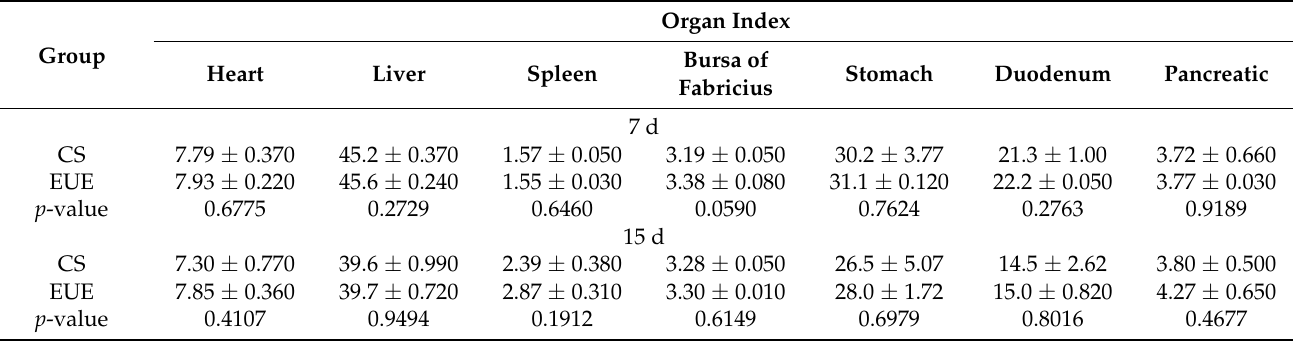
Table 8. The organ index of chicks under cold